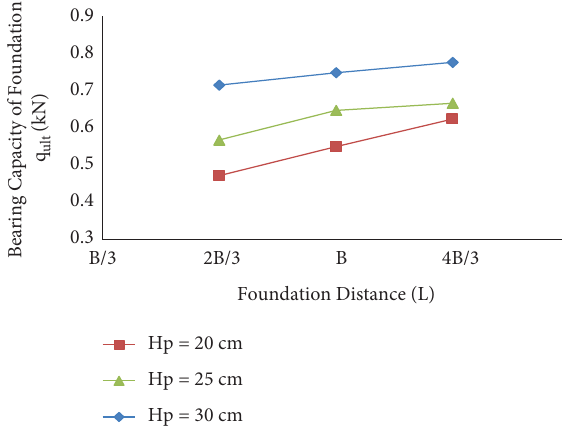
Figure 12: Changes of q